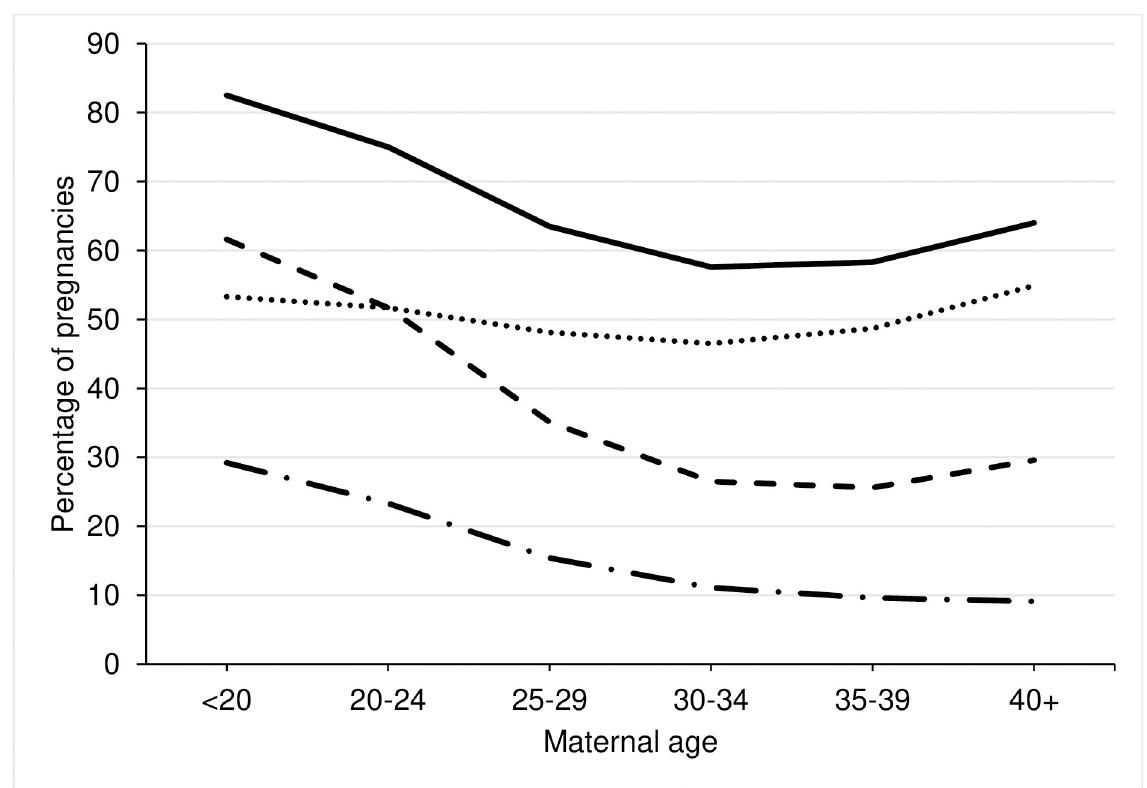
Fig 2. Percent of pregnancies with any medication, non-supplement medication, any supplements (vitamins, iron or folic acid) and only supplements recorded by maternal age. Solid black line = any medication; Dotted black line = non-supplement medication; Dashed black line = any supplements; Long dashed black line = only